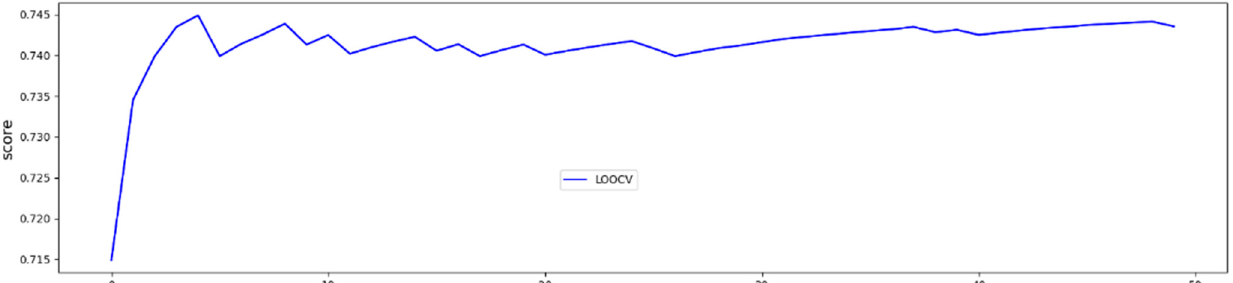
Figure 4. 50 trials and averaged test accuracies for each LOOCV trial. Table 4. performance GBoost classifier on the dataset with and without RF ‐ RFE.